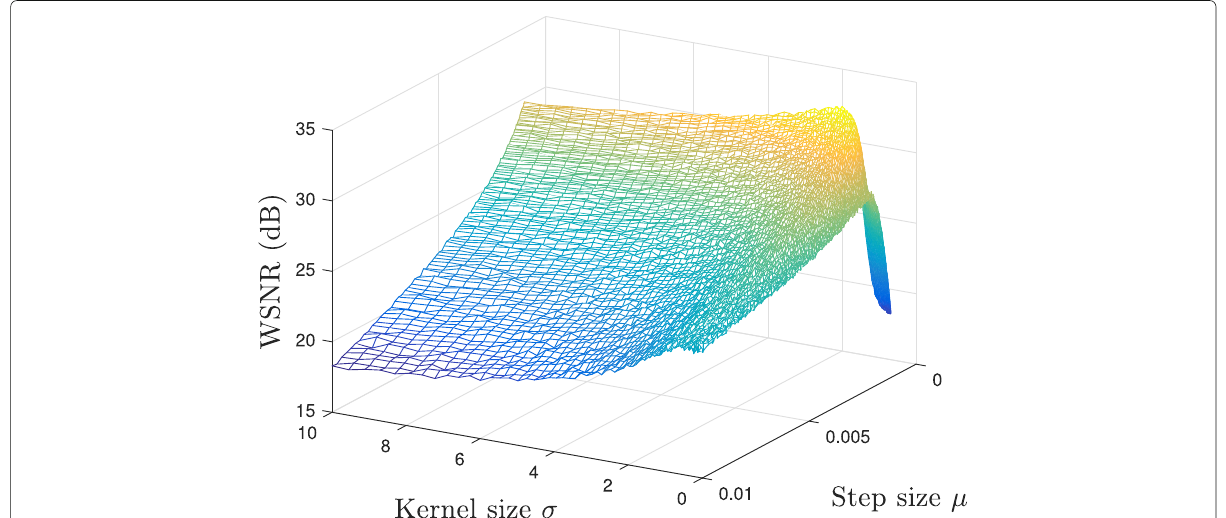
Fig. 6 WSNR performance of the AMCCC algorithm as a function of the kernel size parameter σ and the gradient step size μ . The noise environment is model by a stable distribution with α = 1.5 and GSNR = 20 dB